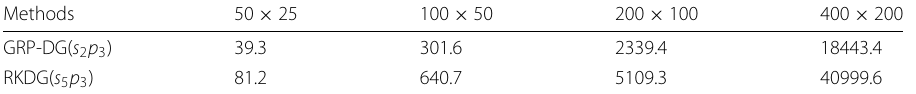
Table 2 Comparison of CPU time(s) between RKDG and GRP-DG methods for shock vortex interaction